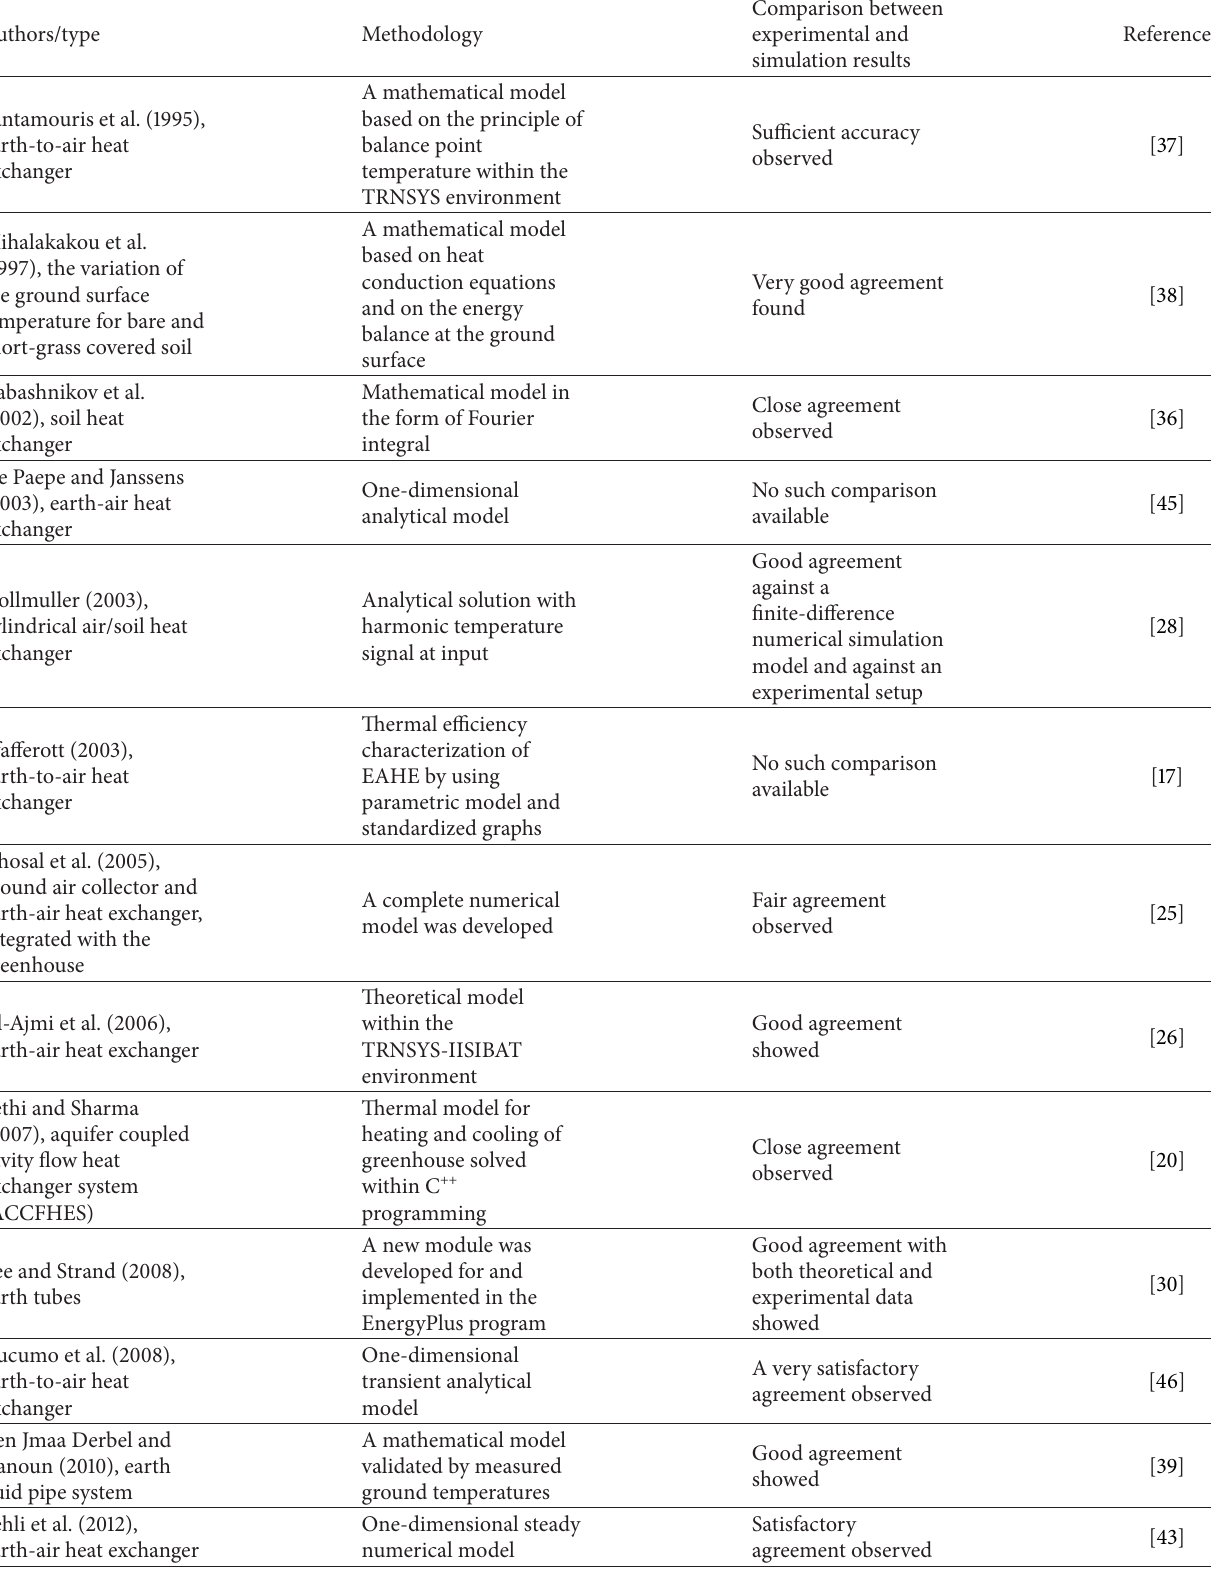
Table 1: One-dimensional calculation models of EAHE